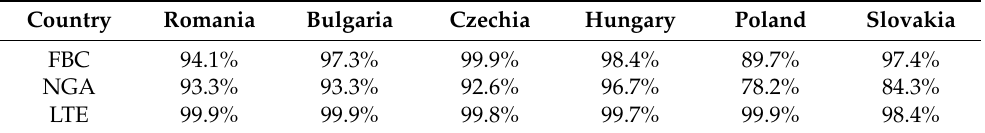
Table 3. Broadband networks coverage in